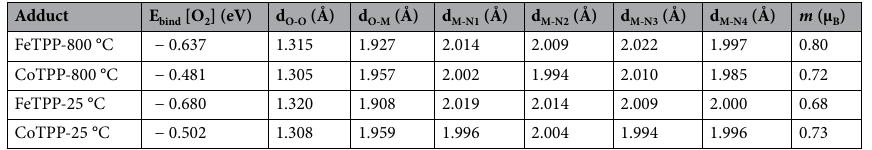
Table 1. Bond distances and binding energy of O 2 adsorbed on the metal center of FeTPP and CoTPP molecules, free standing and supported on carbon ( a -C). d O-M is the distance between O and M atoms (M = Co, Fe), d M-N is the distance between M and the N atoms, and m is the magnetic moment of the systems. The bond length of gas-phase O 2 is calculated to be of 1.234 Å.